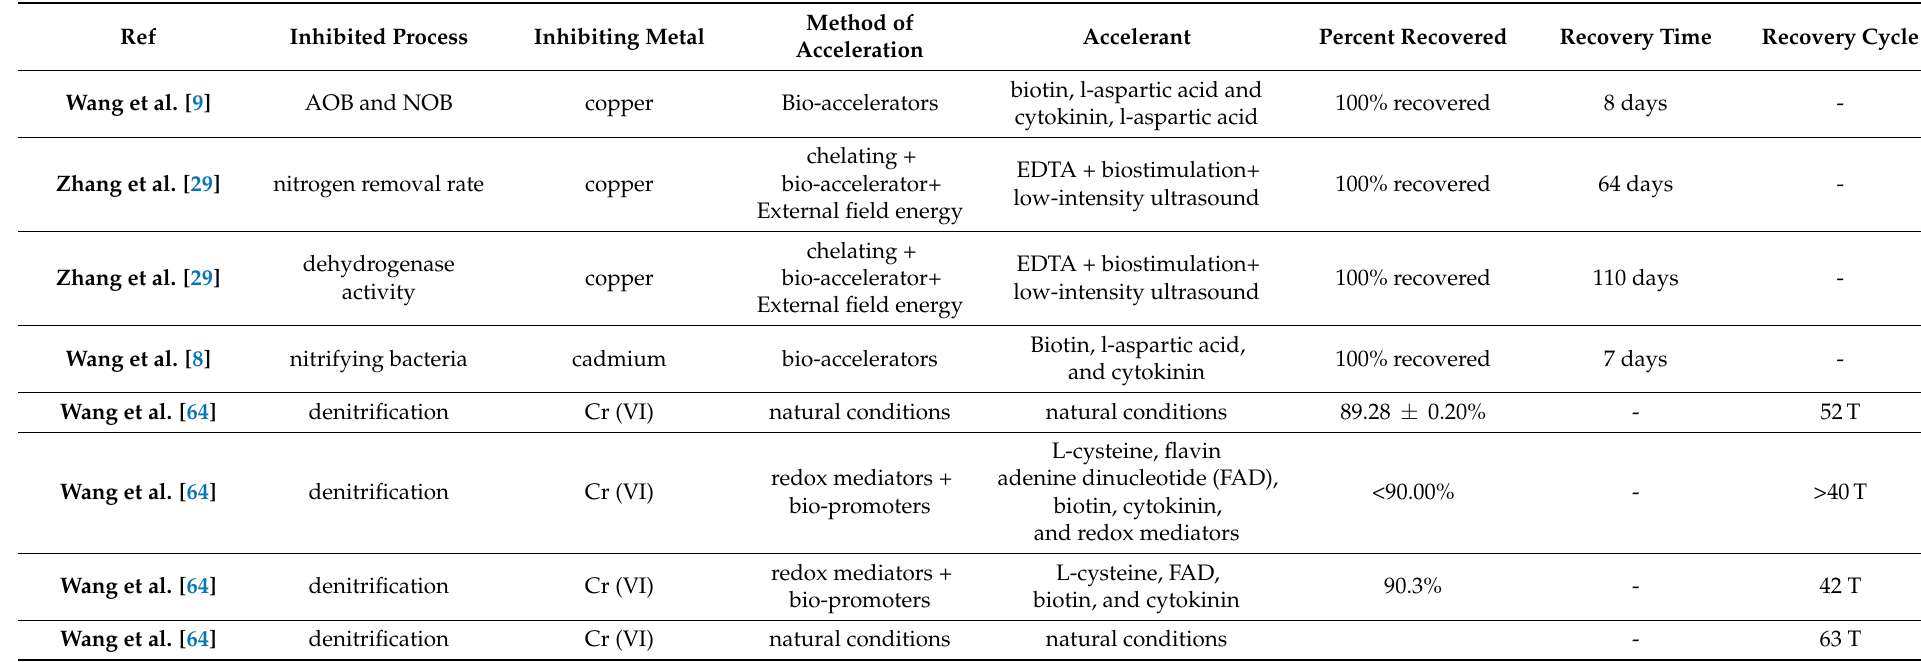
Table 2. Comparison of different recovery strategies for recovery of heavy metal inhibited biological